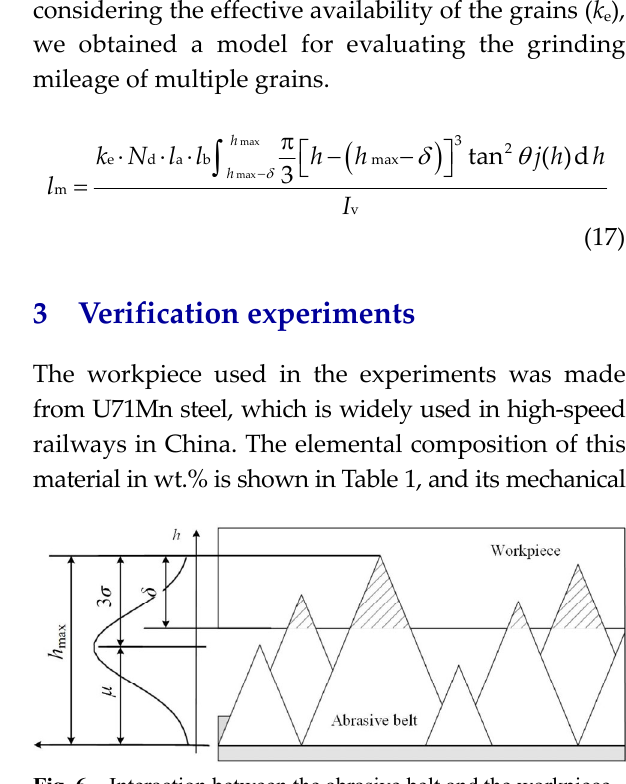
Fig. 6 Interaction between the abrasive belt and the